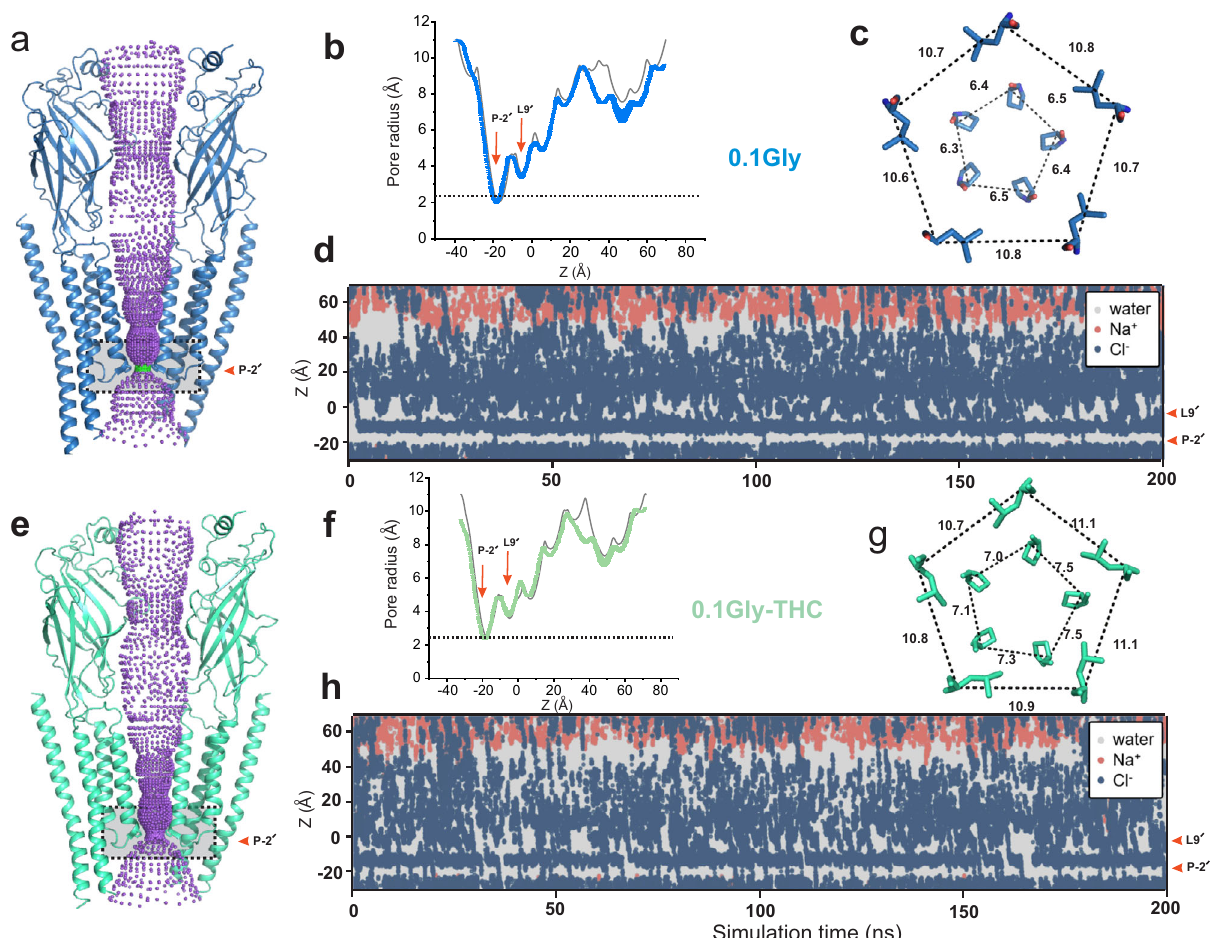
Fig. 4 | Assessment of conductance state of GlyR conformations. a Ion per- meation pathway generated with HOLE for GlyR-0.1gly structure. For clarity, only twonon-adjacentsubunitsareshown.Colorsofthespheresrepresentthefollowing pore radii: red <1.15Å, green 1.8-2.3Å and purple >2.3Å. Residues lining various pore constrictions are shown as sticks. Gray box is shown to highlight the con- striction at Pro-2 ′ position. b Mean pore radius and one-standard-deviation (from three independent 30ns equilibrium simulations for the GlyR-0.1gly structure) plotted along the central pore axis (colored lines) . The fi nal 20ns of each 30ns simulation trajectory was used to evaluate these pro fi les. Major constriction sites are indicated and the black dotted line denotes the radius of hydrated chloride ions.Thegraylineistheporeradiuspro fi lecalculatedfromthecryo-EMstructures. c .AviewofLeu9 ′ andPro-2 ′ positionsfromtheextracellularendfortheGlyR-0.1gly structure.PositionsLeu9 ′ andPro-2 ′ areshowninball-and-stickrepresentationand the corresponding distances between C α are given in Å. d Simulation